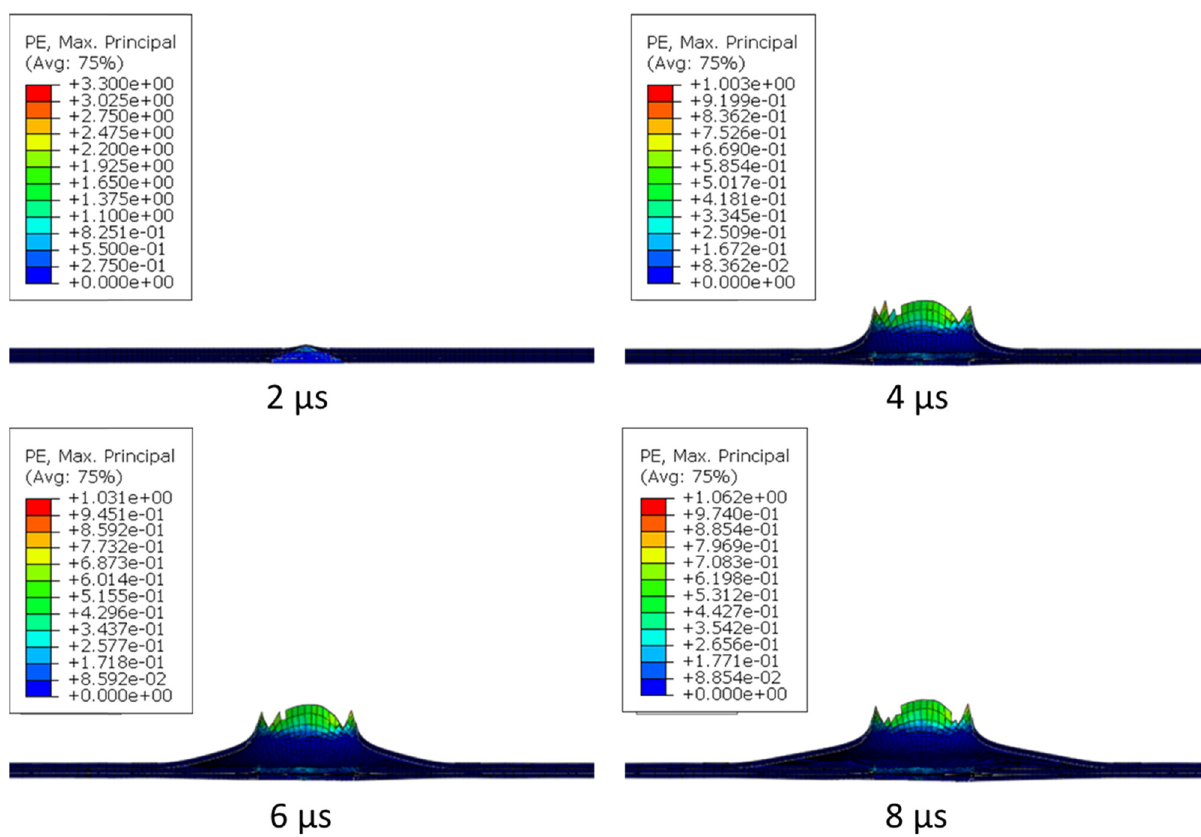
Figure 17: Plastic strain distribution and deformation for model 12 against hemispherical projectile.